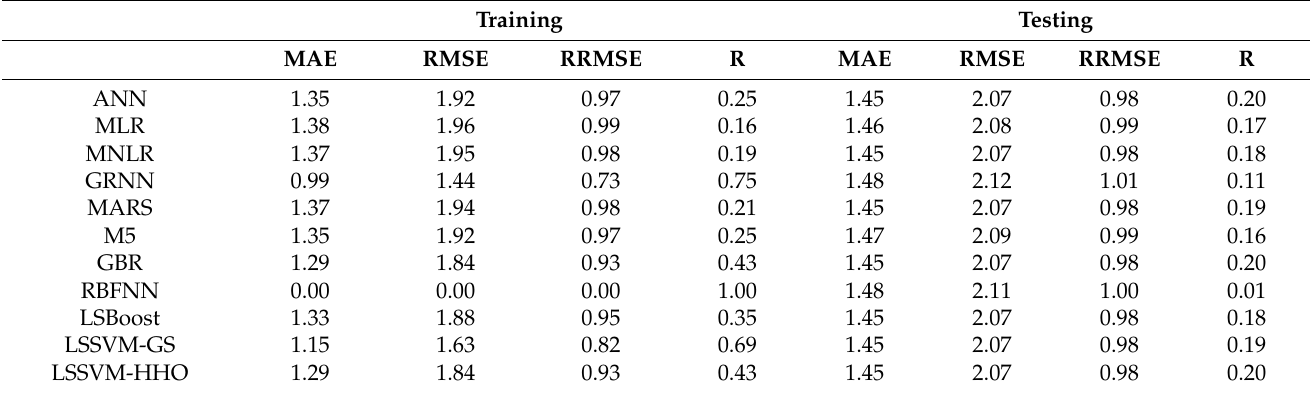
Table A3. Results of modeling WS with the base algorithms in the Golmakan station. Training Testing